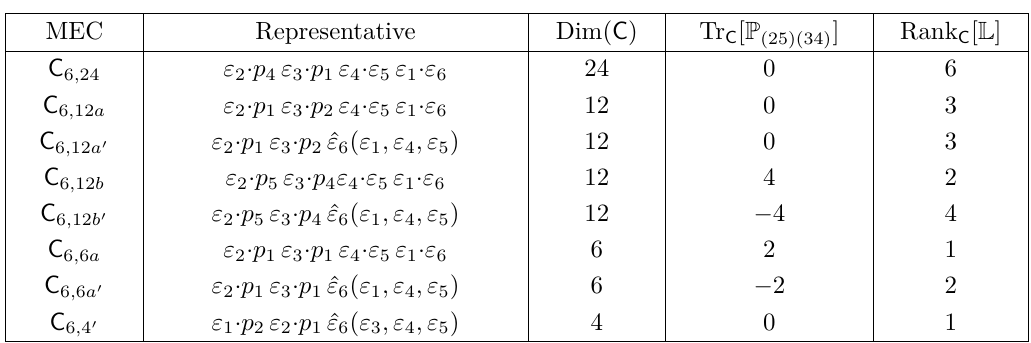
Table 1 . Examples of MECs at n = 6 and the rank of L (2 , 3 , 4 , 5)